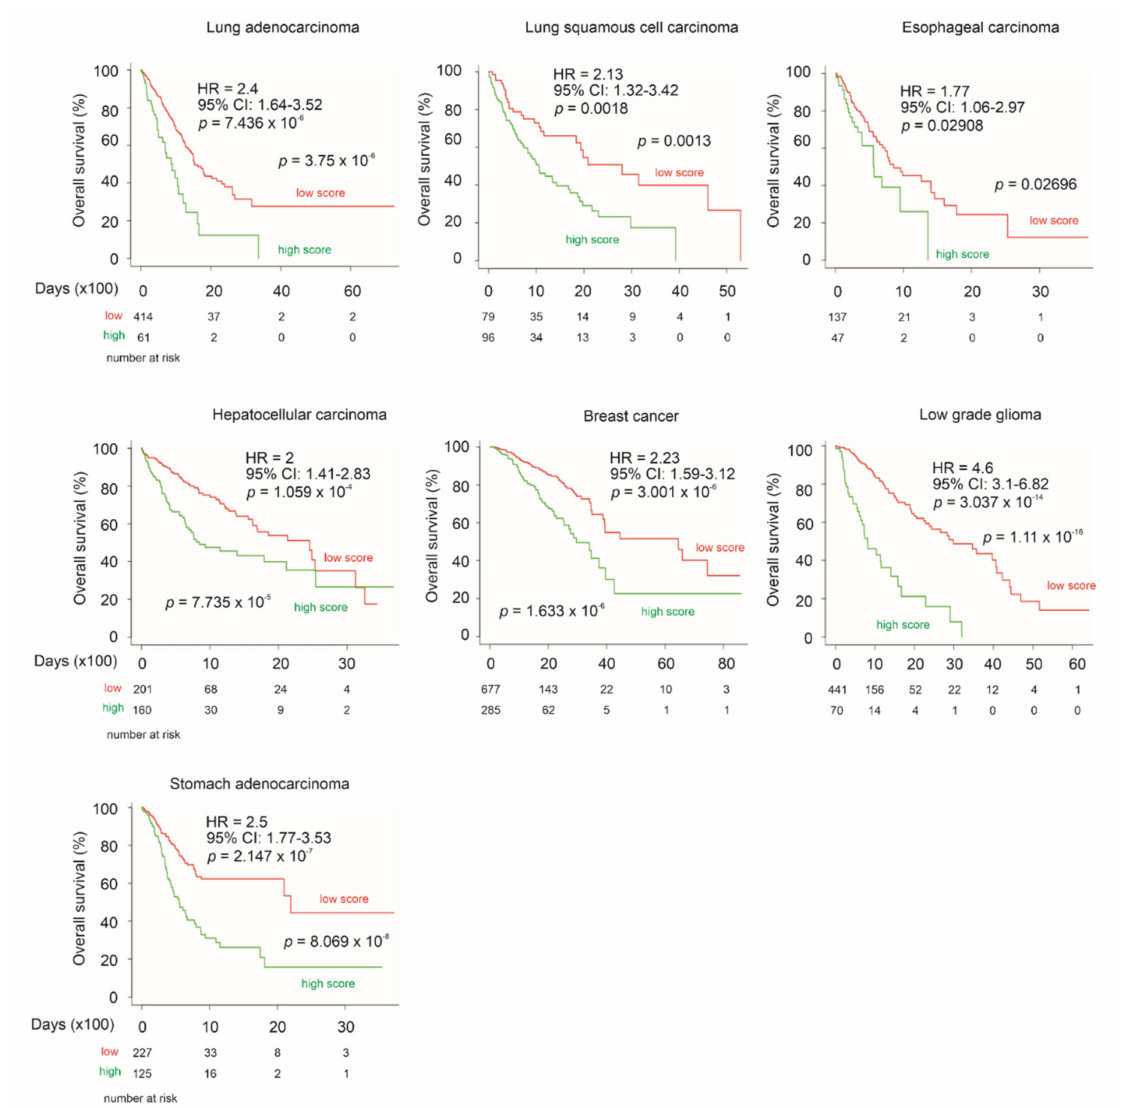
Figure 13. LE gene panel predicts poor OS in multiple cancer types with reported relationship with CNTN1 expression. The above datasets were organized by SurvExpress; specifically, lung adenocarcinoma ( n = 475), lung squamous cell carcinoma ( n = 175), esophageal carcinoma ( n = 184), hepatocellular carcinoma ( n = 361), breast cancer ( n = 962), low grade glioma ( n = 512), and stomach adenocarcinoma ( n = 352) were all from TCGA. HR and 95% CI (confidence interval) for individual analyses are included. Kaplan–Meier survival curves are shown. Statistical analyses were performed using log rank test. All analyses were carried out using tools provided by